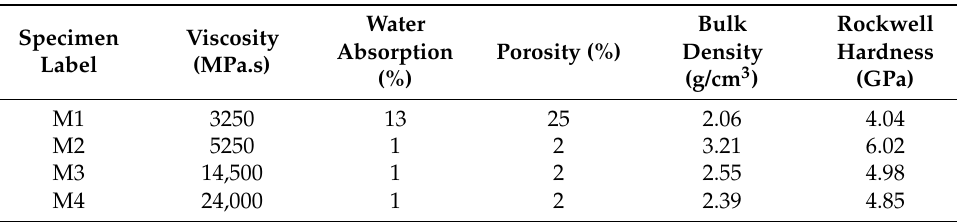
Table 9. The results of viscosity and mechanical properties at different mixing times. Specimen